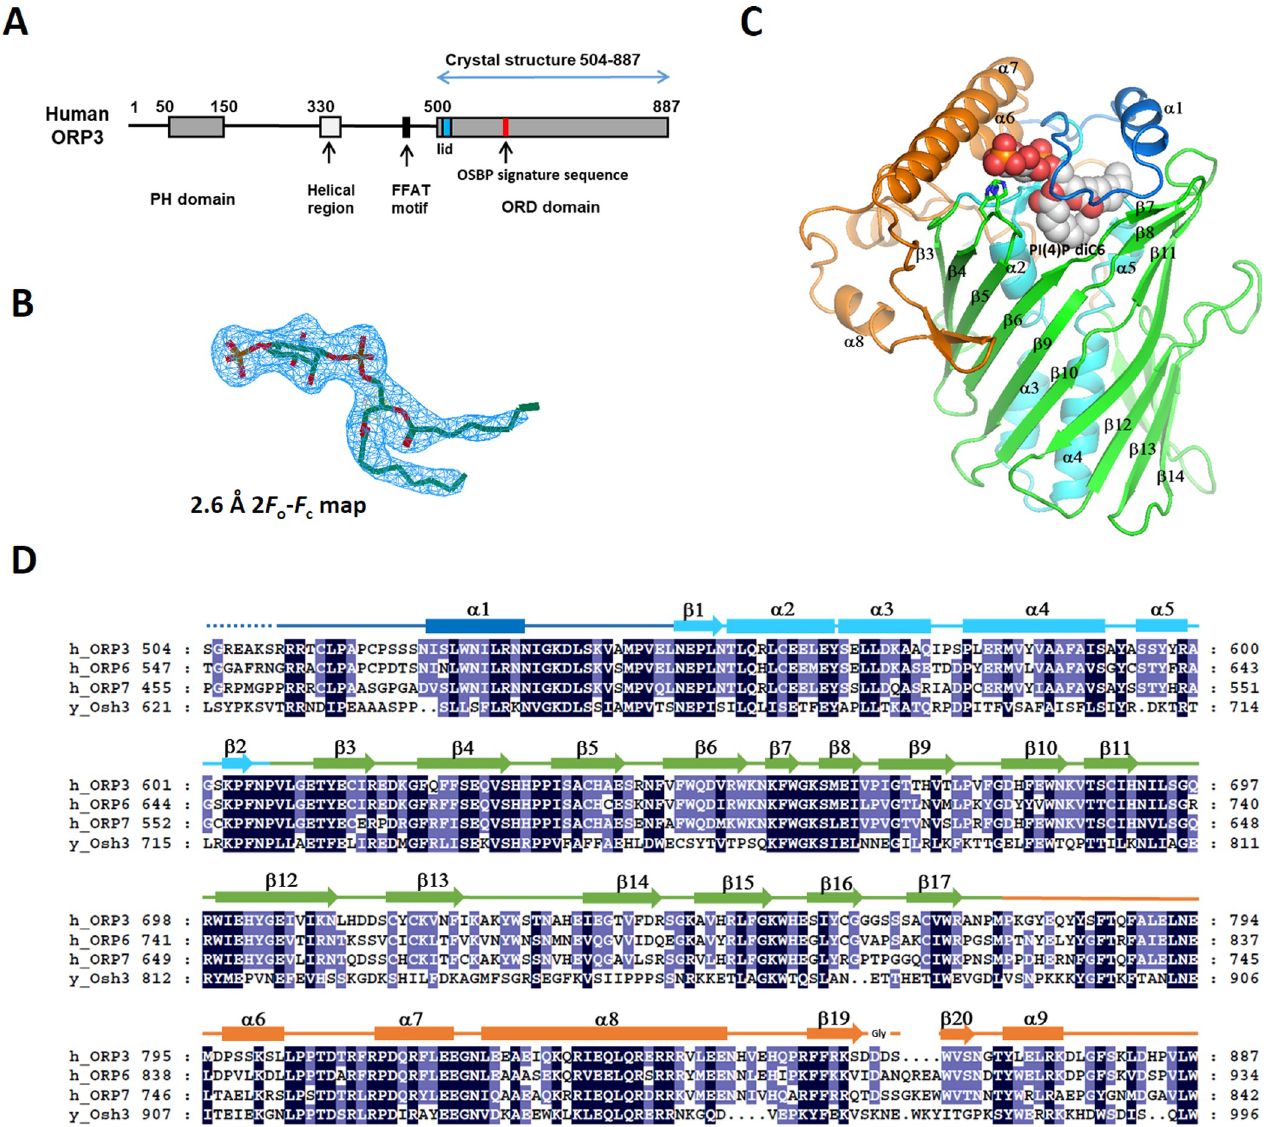
Fig 1. Structure of the ORP3 ORD. (A) Schematic representation of the domain structures of human ORP3. (B) 2.6 Å 2 F o - F c electron density map of the PI(4) P diC6 contoured at 1 σ . (C) The overall structure of ORP3 ORD. The N-terminal lid (residues 511–547) is shown in blue, the central helices (548–608) in cyan, the β -barrel (609–772) in green and the C-terminal subdomain (773–886) in orange. Bound PI(4)P diC6 is shown in a sphere model. (D) Sequence alignments of the ORD domains of human ORPs and yeast Osh3.